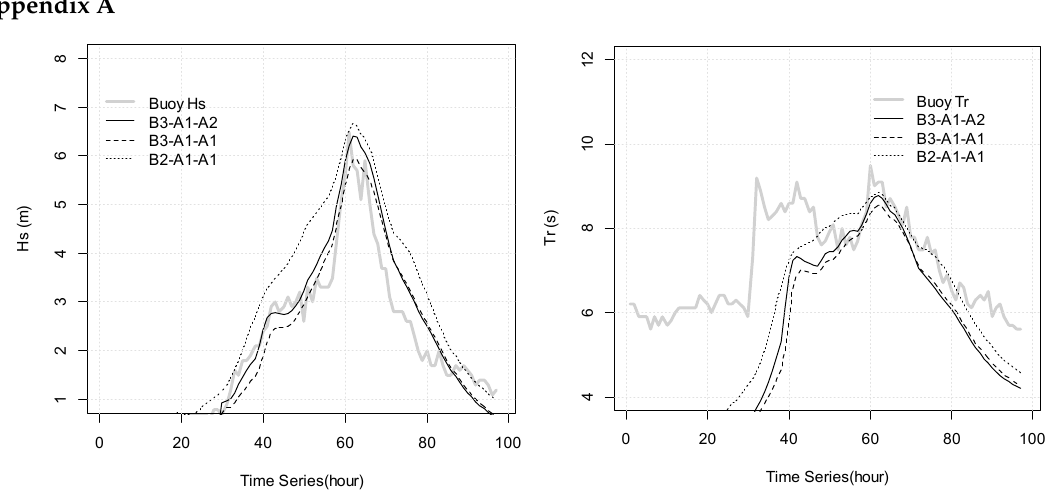
Figure A2. Comparison of typhoon waves induced by Typhoon Nock-ten (08-2011) at buoy QF302: the standard H10 is indexed as B2-A1-A1, the model with varying parameter b without an asymmetric typhoon structure is indexed as B3-A1-A1, and MH10 is indexed as B3-A1-A2.